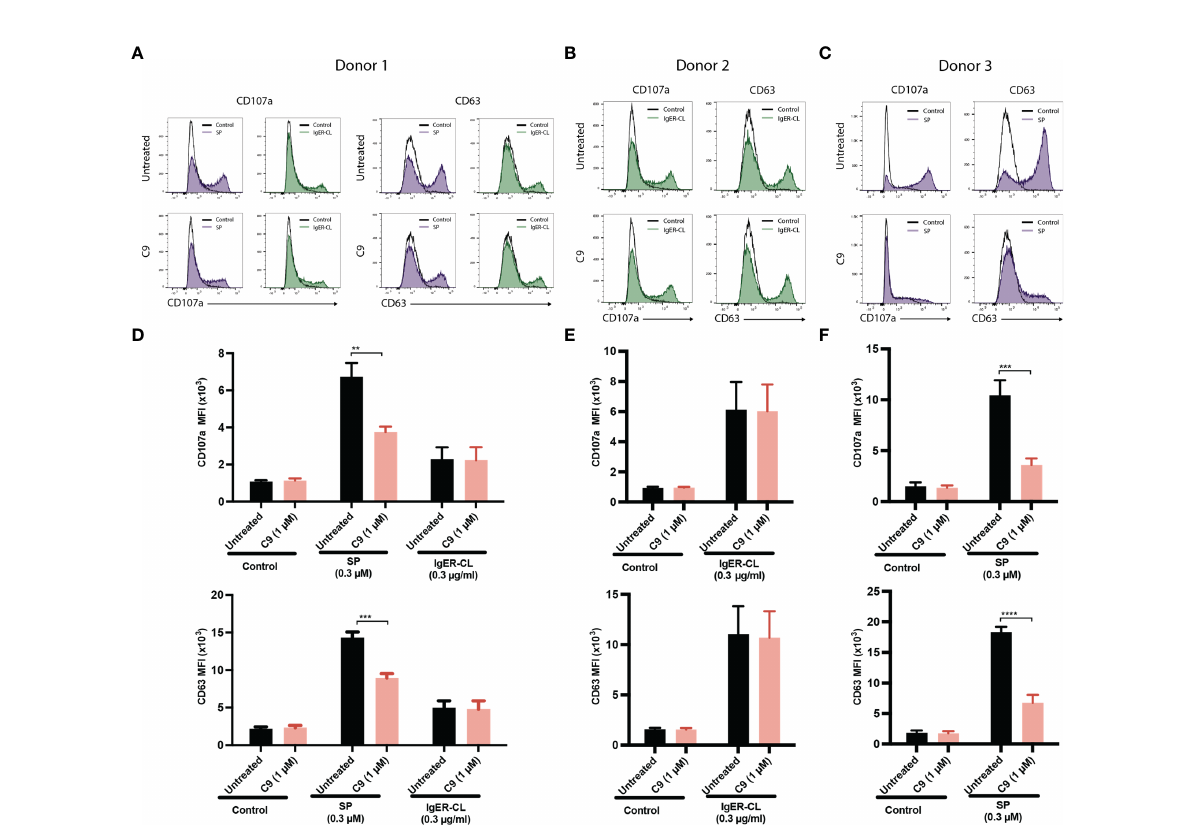
FIGURE 4 C9 inhibits the upregulation of cell surface expression of CD107a and CD63 in response to SP in human skin-derived MCs. (A-C) Cells from three donors were preincubated with buffer or C9 (1 µM, 5 min), stimulated with SP (0.3 µM) or Fc ϵ RI a -aggregation antibody, IgER-CL (0.3 µg/ ml) for an additional 5 min and cell surface expression of CD107a and CD63 was determined by fl ow cytometry. Representative histograms of CD107a and CD63 expression are shown. (D – F) The mean fl uorescent intensity (MFI) levels of CD107a and CD63 are shown. Data are expressed as mean ± SEM. Statistical signi fi cance was determined by two-way ANOVA test at a value ** P < 0.01, *** P < 0.001, and **** P < 0.0001.